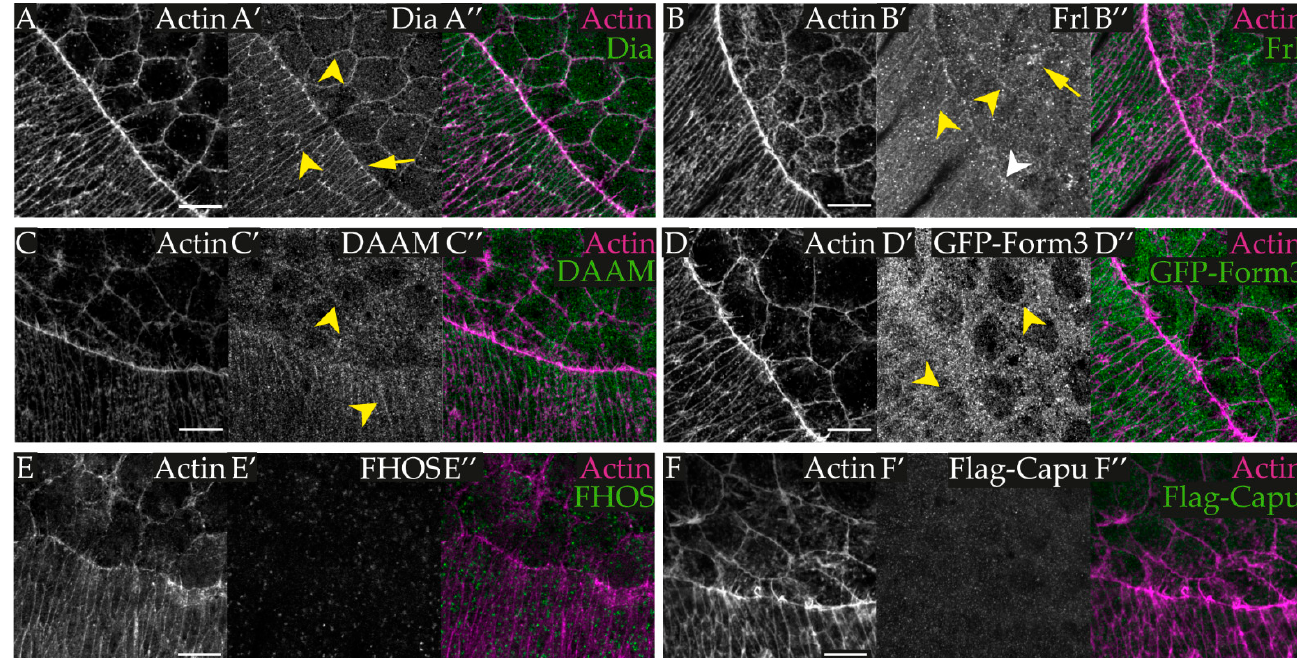
Figure 2. Localization pattern of the formin proteins during dorsal closure. ( A – C’’,E – E’’ ) w 1118 embryos, ( D – D’’ ) Form3-GFSTF, and ( F – F’’ ) Capu-GFSTF embryos. Antigens are as indicated. ( A – A” ) Dia exhibits a strong cortical localization (arrowheads) both in the LE and AS cells, as well as a junctional accumulation (arrow) in the DME cells. ( B – B” ) Frl displays a weak cortical localization (yellow arrowheads) in the DME and AS cells, a weak accumulation along the LE actin cable (white arrowhead), and a non-uniform cytoplasmic accumulation and a mostly punctual nuclear signal in the AS cells (yellow arrow). ( C – C” ) DAAM exhibits a cortical localization (arrowheads) in the LE cells and a somewhat weaker one in the AS cells, together with a weak accumulation in the cytoplasm of the AS cells. ( D – D” ) The Form3 protein is also present both in the LE and AS cells with a weak cortical and a more profound cytoplasmic accumulation in both cell types (arrowheads). We failed to detect a specific staining pattern in the cases of Fhos ( E – E” ) and Capu ( F – F” ). Scale bars: 10 µm.